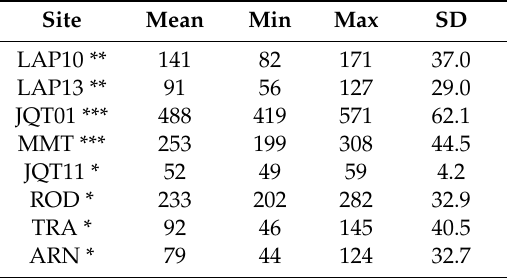
Table 2. Means, minima, maxima and standard deviation for PM mass concentrations ( µ g m -3 ) of samples collected at each site. Site Mean Min Max SD LAP10 ** 141 82 171 37.0 LAP13 ** 91 56 127 29.0 JQT01